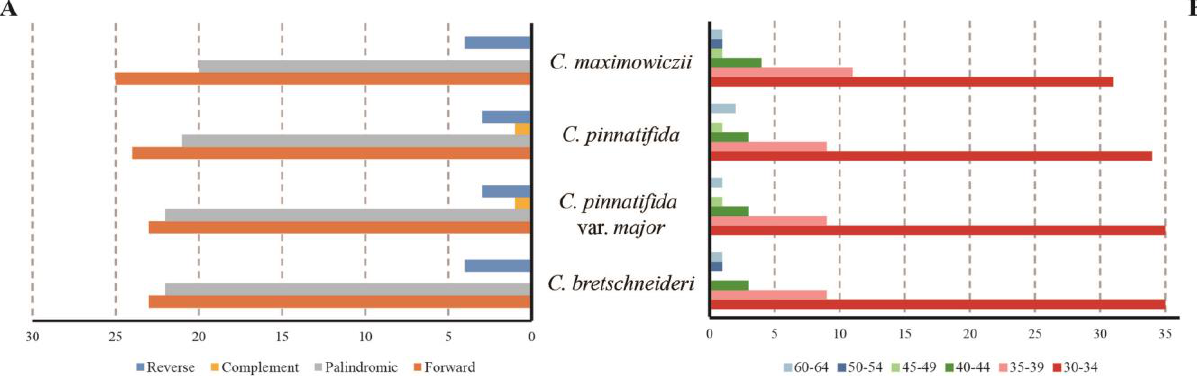
Figure 6. Analysis of repeat sequences in the four Crataegus plastomes. ( A ) Numbers of different types of repeat sequences. ( B ) Length distribution of repeat sequences in their respective plastomes.